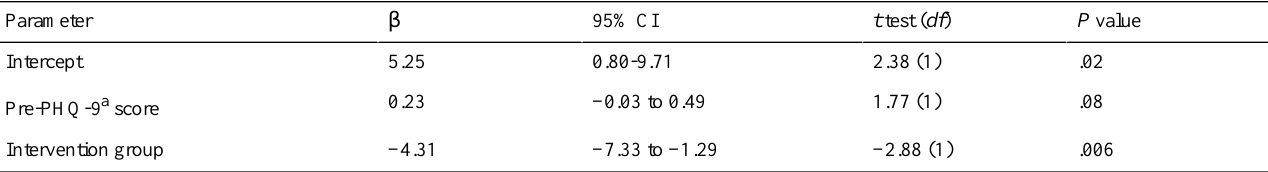
Table 3. Adjusted postintervention depression score (dependent variable) and treatments using analysis of covariance.